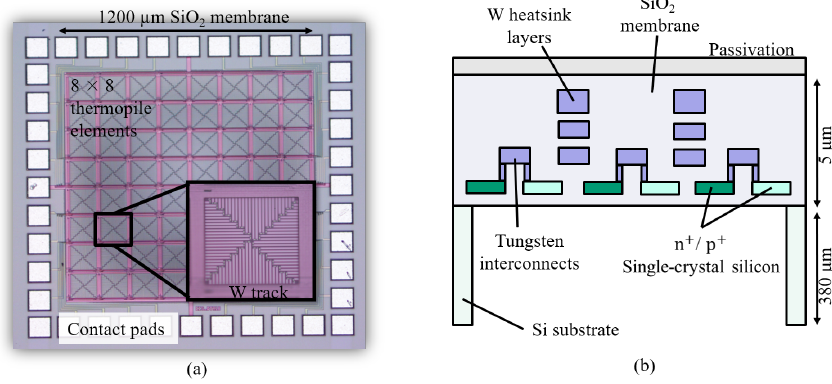
Figure 1. ( a ) Optical image of the thermopile array with a magnified image (colour-shifted) of an individual pixel. Chip size = 1.76 mm × 1.76 mm. ( b ) Cross-sectional view of the numerical model (not to scale) showing the single-crystal Si p + / n + elements and tungsten (W) layers of the thermopile array.